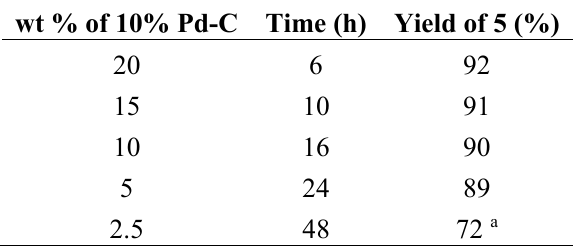
Table 1. Optimization for the dehydrogenation of 4 to 5